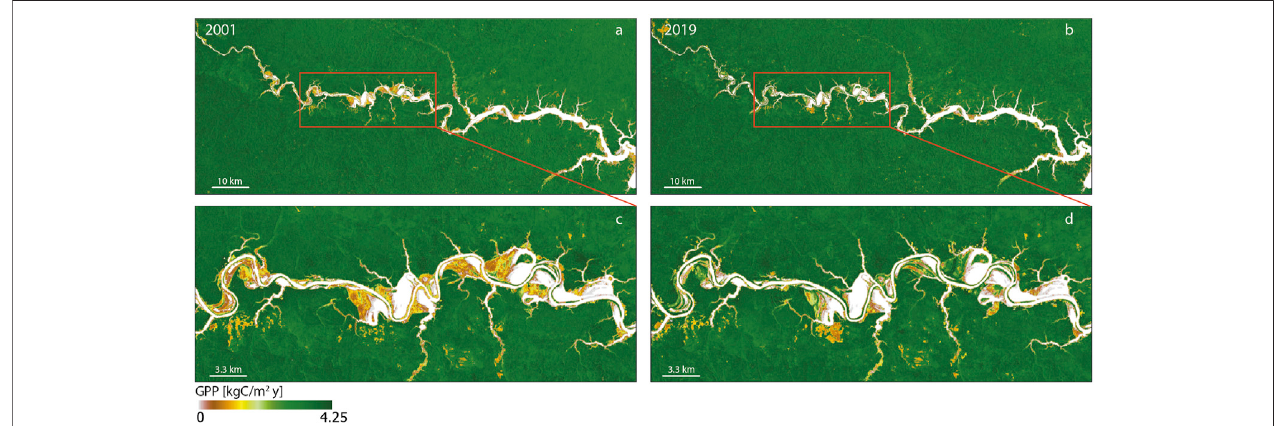
FIGURE9| Comparison betweenannualgross primaryproduction maps (30 m resolution) ofUatum ~ a fl oodplain forestin2001 (A) and 2019 (B) . (C) and (D) detail of river stretch (red box) affected by greatest changes in GPP in 2001 and 2019 respectively.